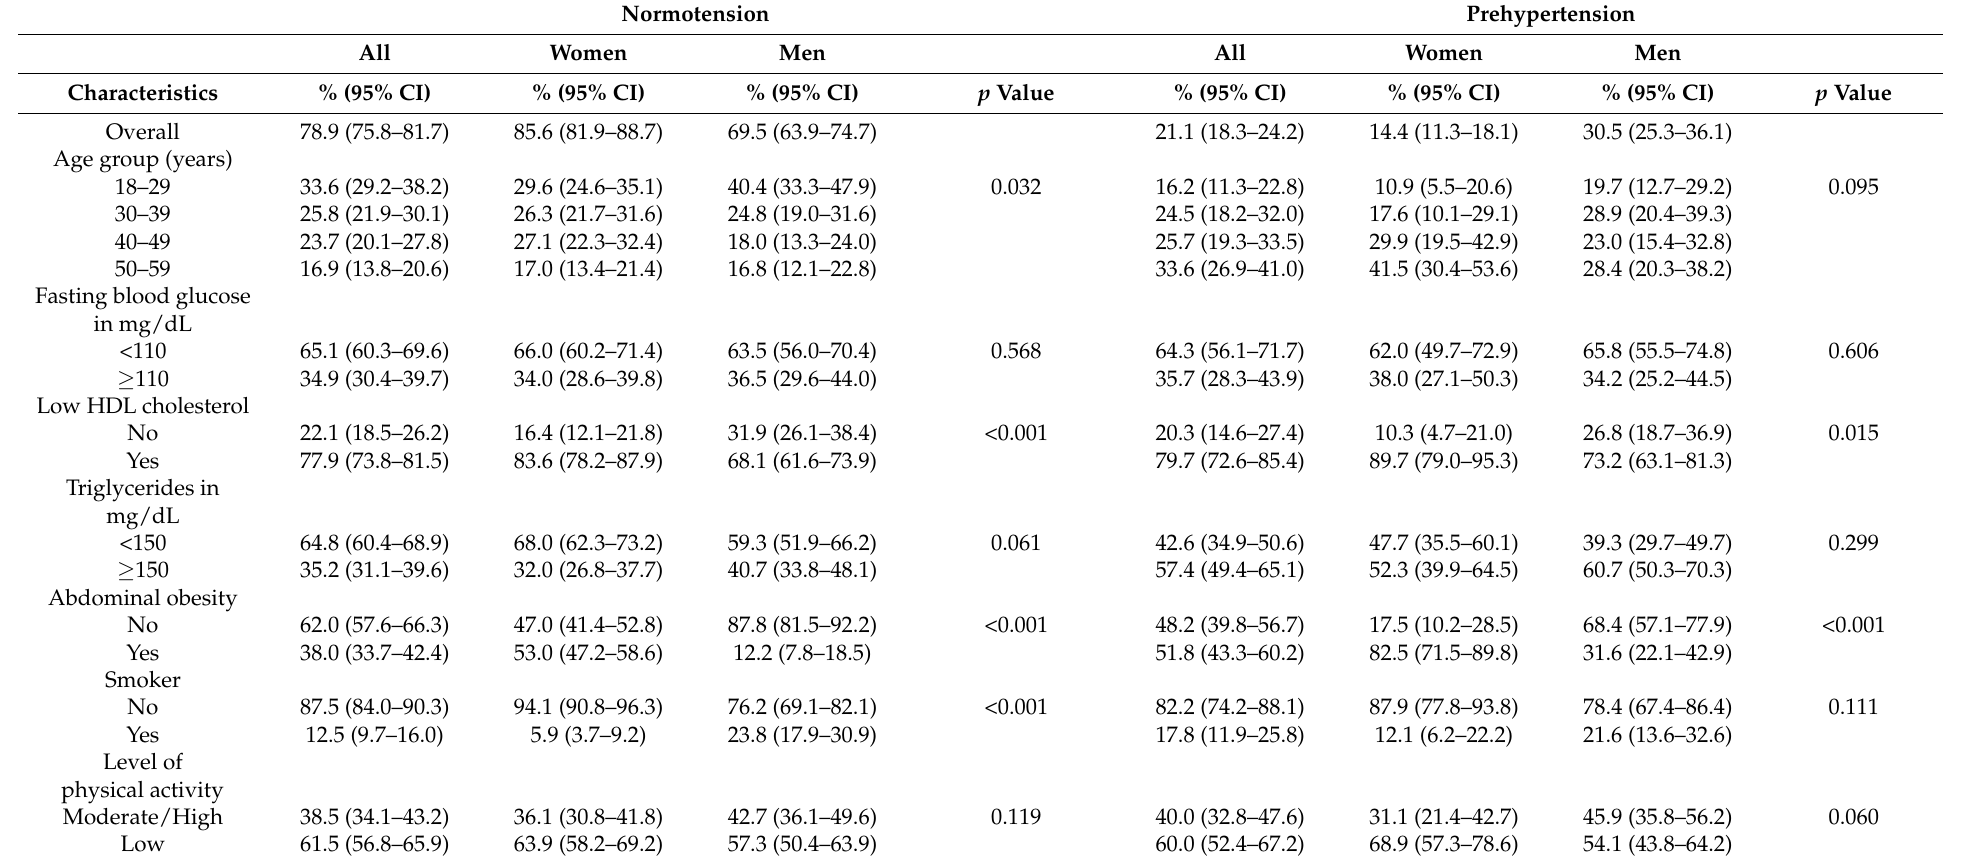
Table 2. Cardiometabolic risk factors according to blood pressure level, 2017–2018